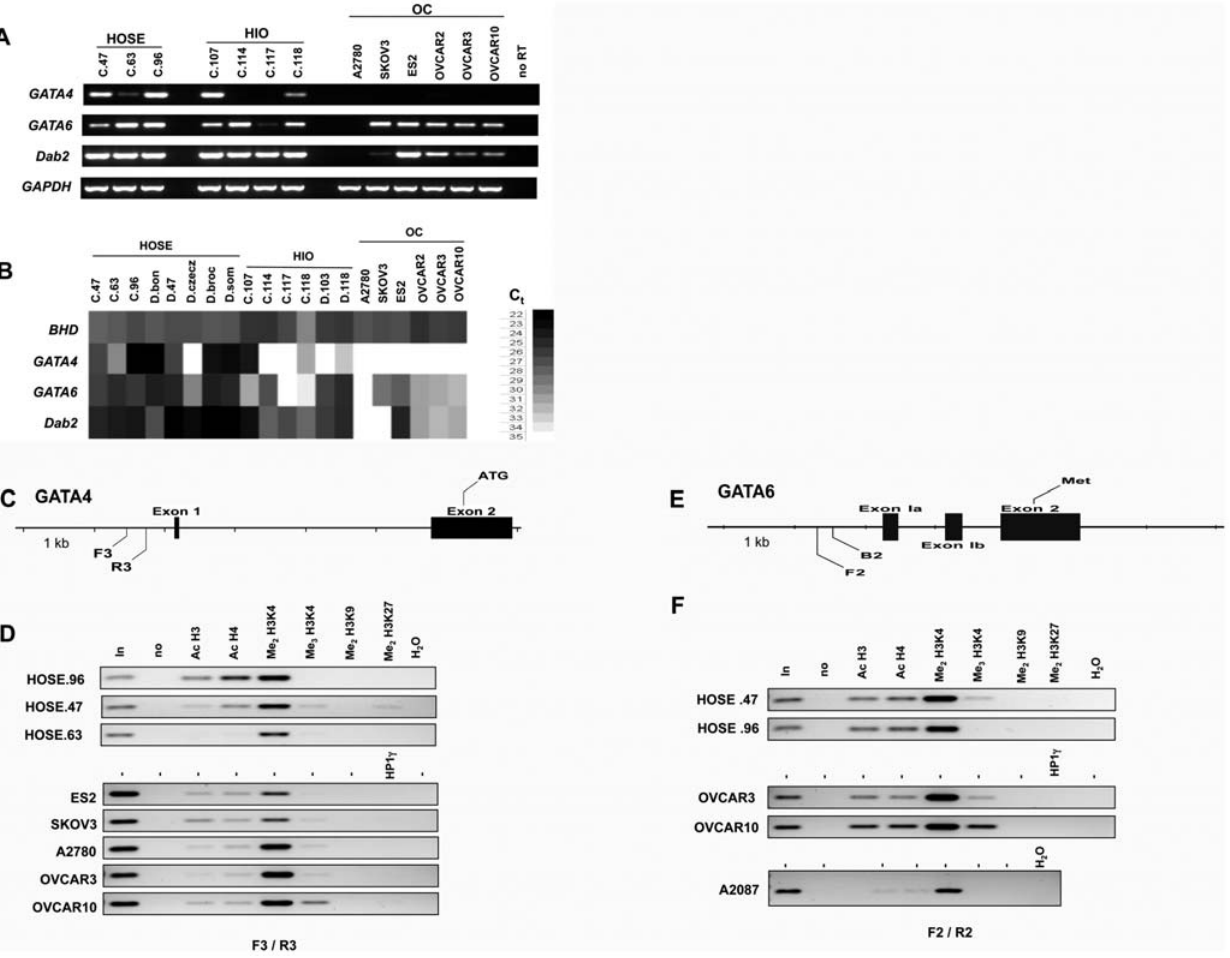
Figure 5. Alterations of histone modifications at GATA4 locus in culturing of ovarian surface epithelial cells. Human ovarian surface epithelial cells were isolated from morphologically normal human ovaries obtained from oophorectomy surgery. Several HIO lines were also established by transfecting the primary cells with SV-40 T-antigen to prolong the life span in cultures. Total RNA isolated from a collection of primary HOSE, HIO, and cancer cells were used for: A . Semi-quantitative RT-PCR, and B . Quantitative real-time RT-PCR, to assay mRNA levels for GATA4, GATA6, Dab2, and GAPDH (semi-quantitative RT-PCR) or BHD (real-time RT-PCR) as loading controls. Sufficient RNA were obtained from HOSE.96 (or C.96), passage # 3; HOSE.47 cells, passage # 5; and HOSE.63 cells, passage # 12; for CHIP assay. C . The location of primers F3 and R3 at GATA4 gene for PCR in the ChIP assay is shown. D . Lysates from HOSE.96, HOSE.47, HOSE.63, ES2, SKOV3, A2780, OVCAR3, and OVCAR10 were prepared for CHIP assay. Chromatin precipitations by antibodies to Ac H3, Ac H4, Me 2 H3K4, Me 3 H3K4, Me 2 H3K9, Me 2 H3K27, and HP c 1 were used to amplify by PCR using primers F3 and R3. The input signal (‘‘in’’, 2% of total chromatins used for immunoprecipitation), no antibody control (‘‘no’’), and no template control (‘‘H 2 O’’) were included. The bright field images of the semi-quantitative PCR products are shown. E . The location of primers F2 and B2 at GATA6 gene for PCR in the CHIP assay is shown. F . Lysate from HOSE.96, HOSE.47, A2780, OVCAR3, and OVCAR10 were prepared for CHIP assay. The bright field images of the semiquantitative PCR products are shown.